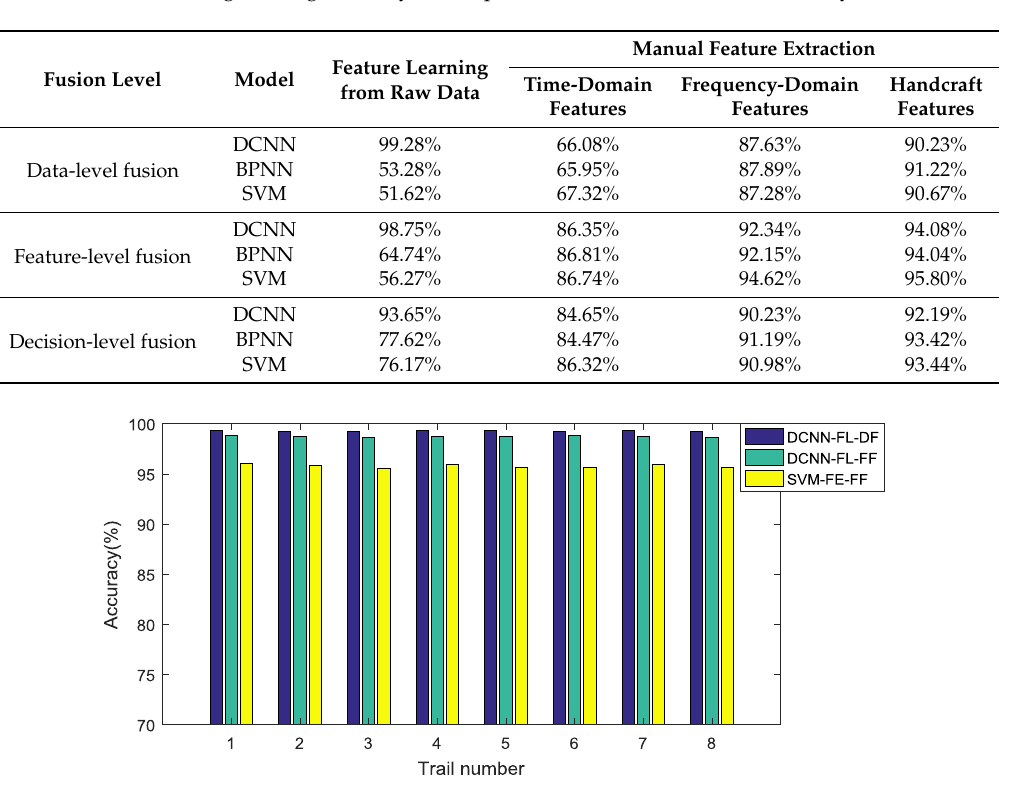
Figure 7. Testing accuracy of eight trials of the top three methods (the proposed method, the DCNN model with feature learning and feature-level fusion, and the SVM model with handcraft features and feature-level fusion). FL = feature learning; FE = manual feature extraction; DF = data-level fusion; FF = feature-level fusion.